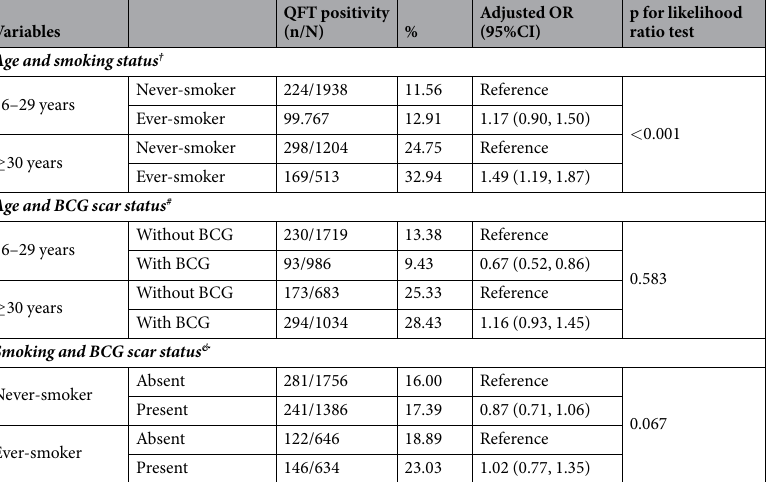
Table 4. The association of QFT positivity between age, BCG status, and smoking status among study populations. Abbreviations: BCG = Bacillus Calmette-Guerin; CI = confidence interval; OR = odds ratio; QFT = QuantiFERON-TB Gold In-Tube. † Adjusted for BCG status. # Adjusted for smoking status. & Adjusted for